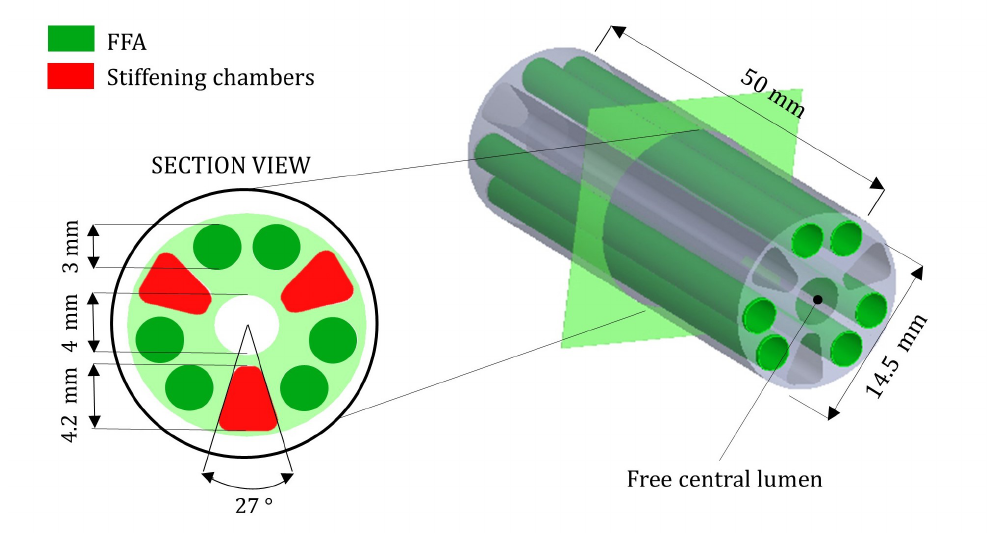
Figure 2. Section view and design of the